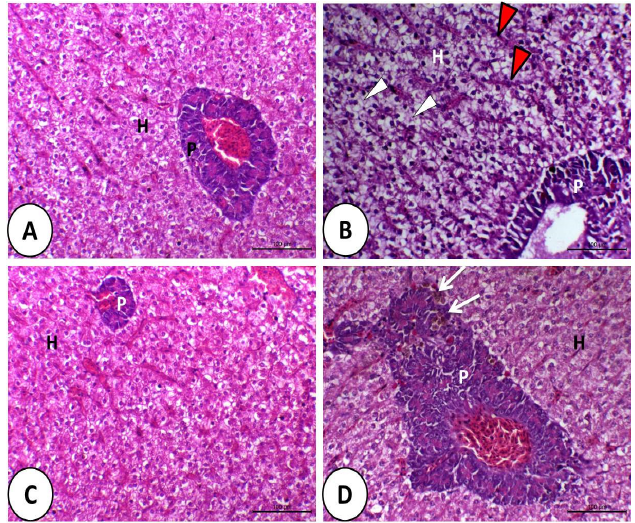
Figure 4. Histology of liver of Nile tilapia in the control ( A ), deltamethrin (DMT) ( B ), synbiotic ( C ), and DMT with synbiotic ( D ) groups. In A and C, the hepatopancreas consists of polyhedral hepatocyte (H) and pancreatic cells (P). The toxic effect of deltamethrin ( B ) causes fatty degeneration (white arrowhead) of hepatocytes and congestion of blood sinusoids (red arrowhead). In ( D ), the hepatopancreas has a relatively normal structure in addition to some melanomacrophages (white arrow), especially in the pancreatic part (P). H&E staining; bar = 100 µ m. The control and synbiotic groups showed a normal structure of the spleen (Figure